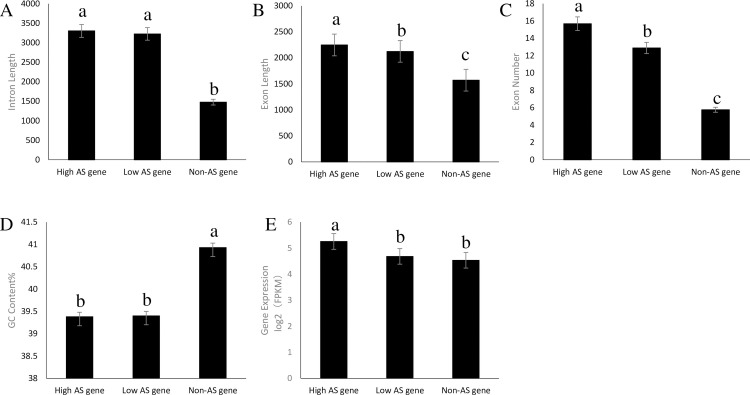
Association between AS events and each factor in the poplar leaves.All the transcribed genes in the poplar leaves were classified into three groups according to AS frequency in each gene as high AS genes (>5 AS events/gene), low AS genes (1–4 AS events/gene), and non-AS genes. A: Intron length, B: Exon length, C: Exon number, D: GC content, E: Expression level. The different letters indicate significant differences at the level of P < 0.05. The bars indicate SE.